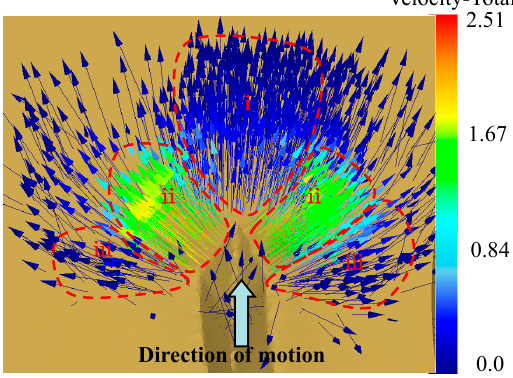
Figure 10. The flow vector of the metal during the process.